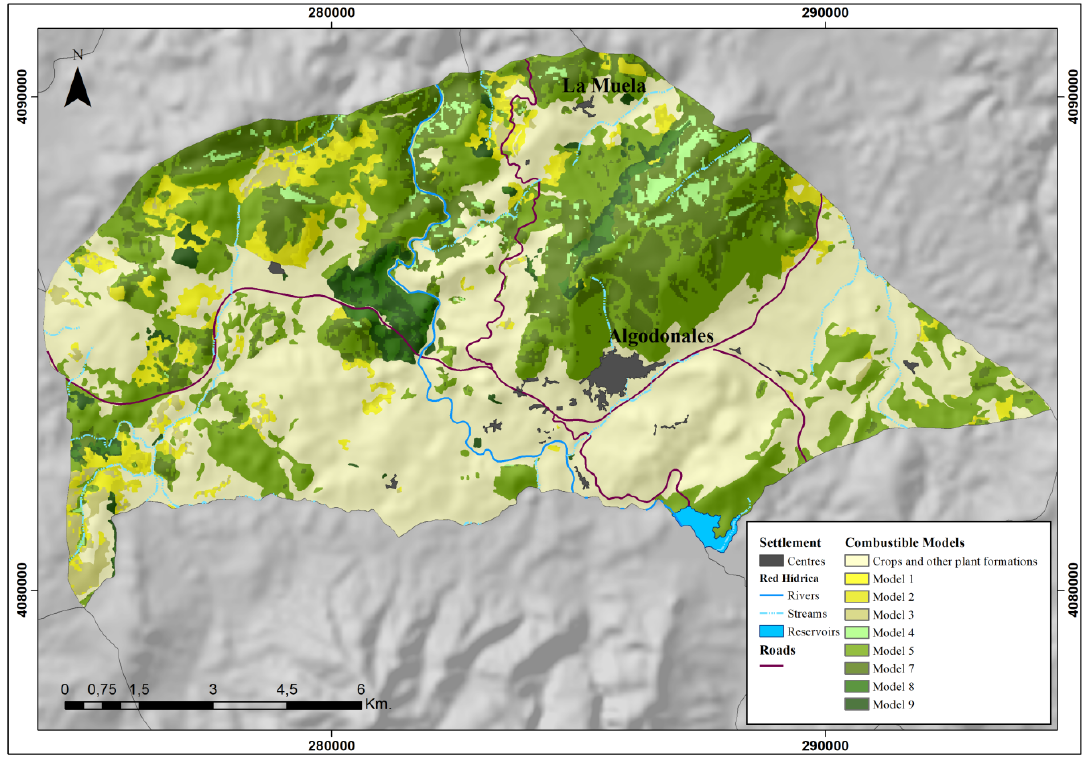
Figure 4. Fuel/combustible models.